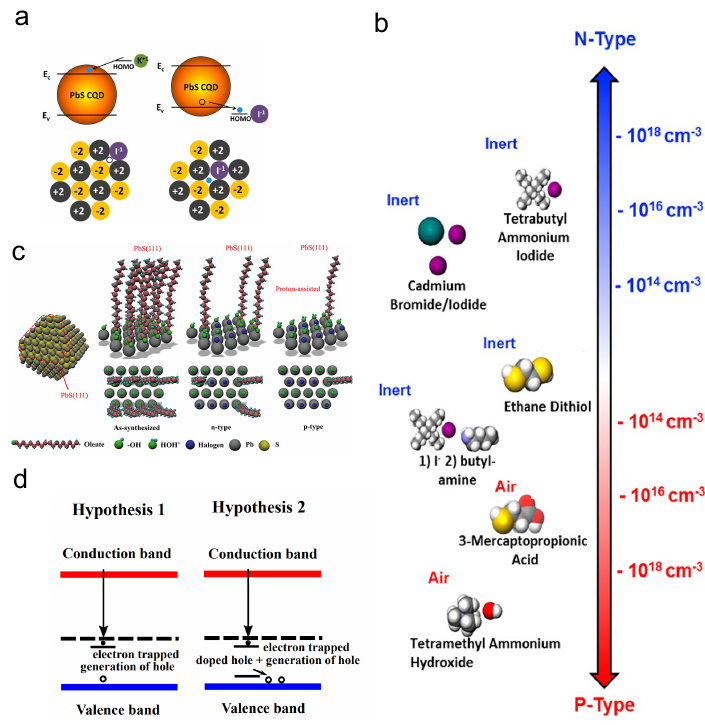
Figure 8. Ligand exchange doping mechanisms: ( a ) Illustration of doping effect caused by a potassium ion and an iodide ion. ( b ) Free carrier concentrations of PbS QDs with different ligands. Reprinted with permission from [109]. Copyright 2012 American Chemical Society. ( c ) Illustration of surface conditions of PbS QD with different ligand exchange process. ( d ) Hypotheses of mechanism of ligand-exchange-induced doping. Reprinted with permission from [100]. Copyright 2020 American Chemical